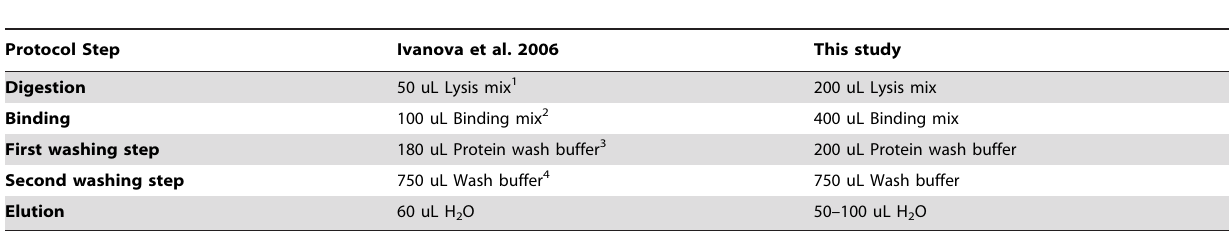
Table 3. Modifications to the genomic DNA protocol of Ivanova et al. 2006 used for sponge barcoding.